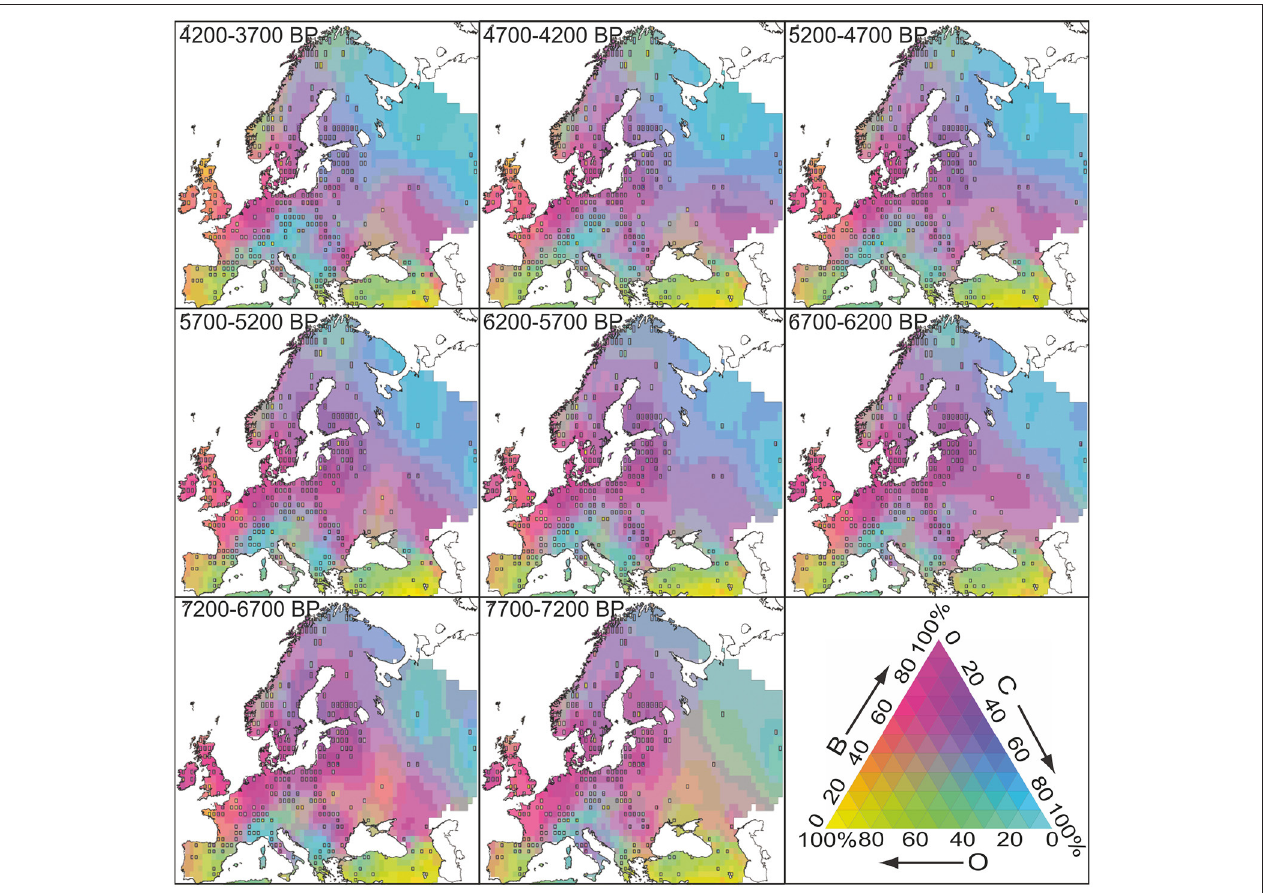
FIGURE 5 | Composite maps of the reconstructed land cover for eight time-windows (7700–3700 BP). The location of REVEALS estimates is marked by squares. The color-key for land-cover composition (C, coniferous forest; B, broad-leaved forest; O, open land) is presented as a triangular color